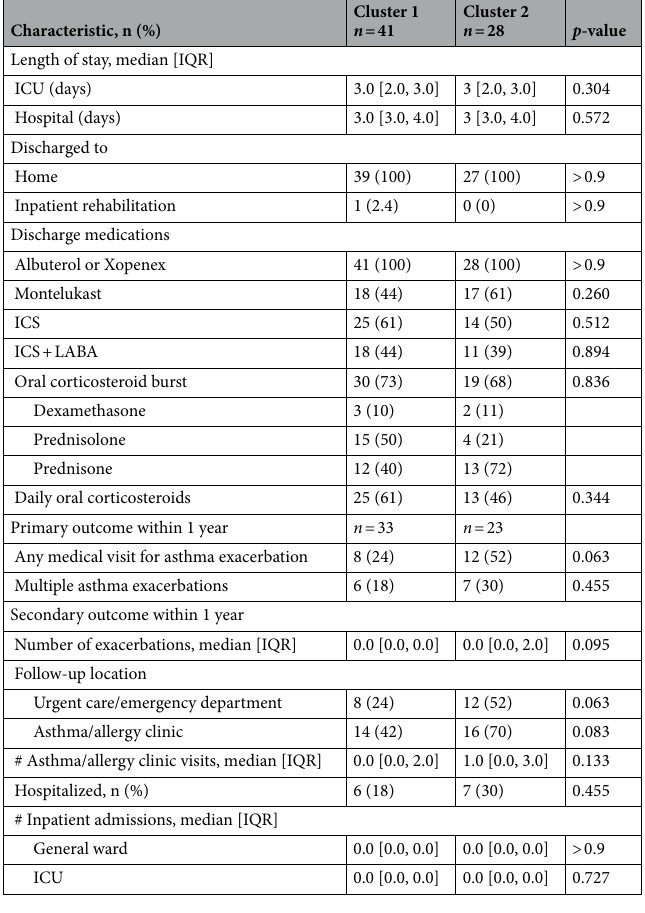
Table 3. Duration of hospitalization and outcomes following hospitalization.